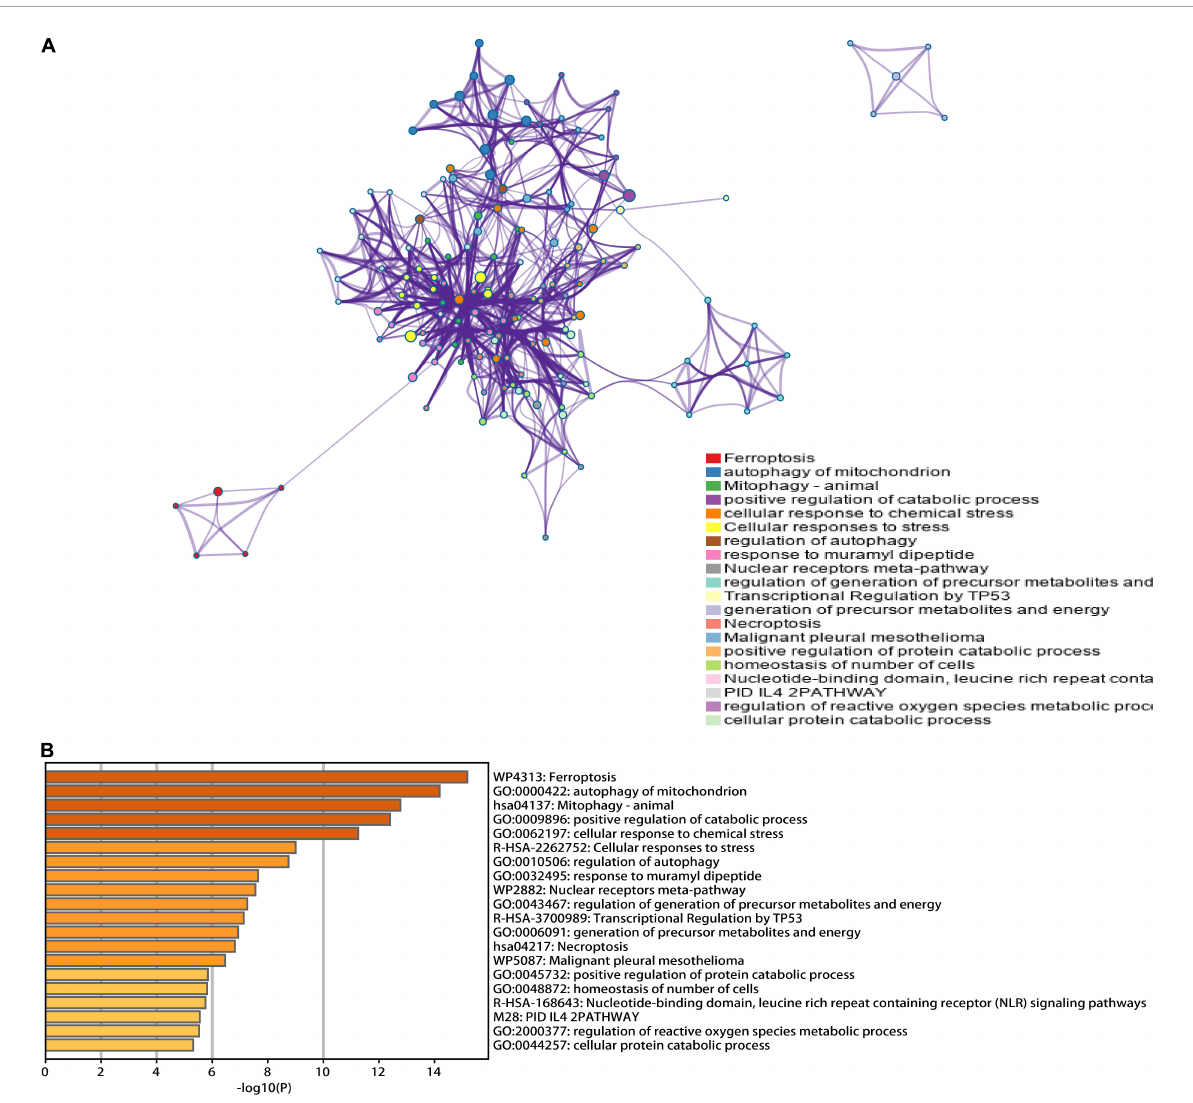
FIGURE3 Functional analysis of 46 hub ferroptosis-related genes. (A) Network of enriched terms. (B) Bar graph of biological pathways according to the p